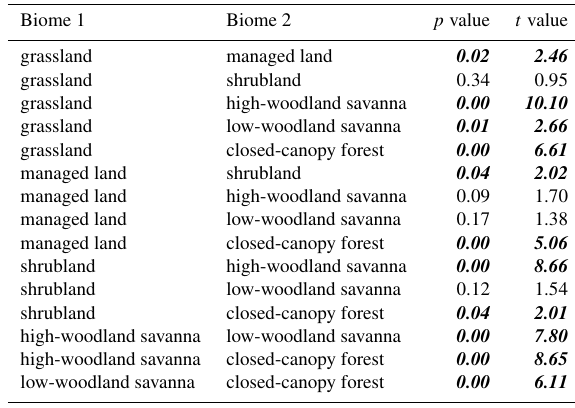
Table B2. Results detailing the statistical significance of the EC b are bold and italicised, while any biome pair with p values above 0.15 are neither bold or italicised.